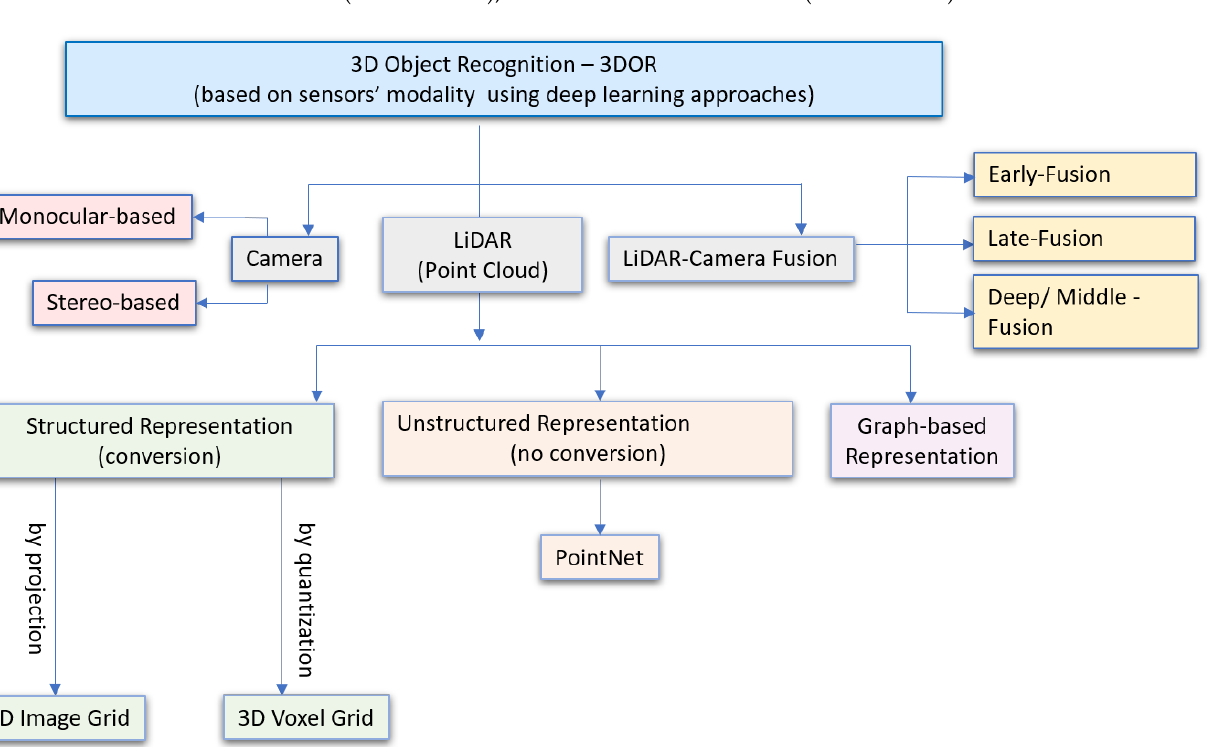
Figure 4. Camera and LiDAR-based Data Representation Modalities for 3D Object Recognition